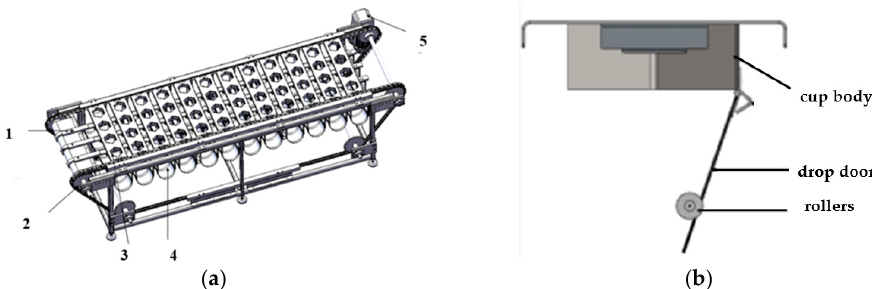
Figure 5. Graded actuators. ( a ) Grading actuator; ( b ) Detail of grading fruit cup. (1-Trigger grading mechanism; 2-Sprocket chain drive; 3-Grading fruit cup; 4-Grading channel; 5-Motor).